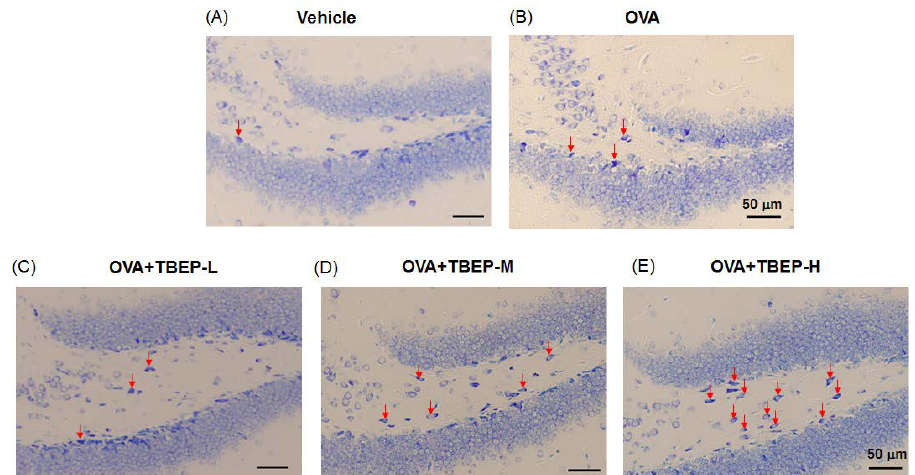
Figure 8. Toluidine blue staining of the dentate gyrus of the hippocampus. Toluidine blue stain showing mast cells in ( A ) vehicle, ( B ) OVA, ( C ) OVA + TBEP-L, ( D ) OVA + TBEP-M, and ( E ) OVA + TBEP-H. Red arrows indicate mast cells. (Scale bar = 50 μm).